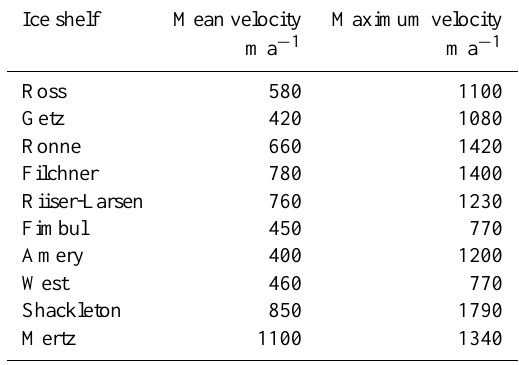
Table 6. Mean and maximum velocity for the ten other ice shelves in